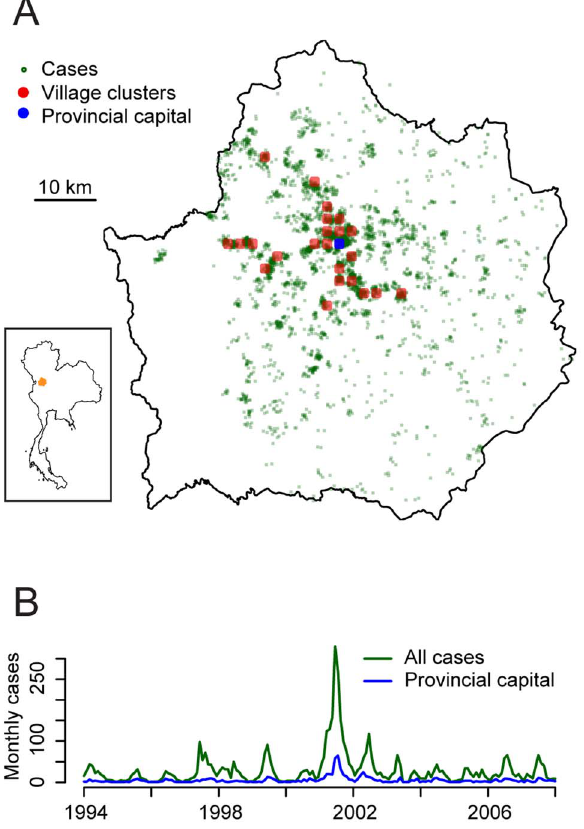
Figure 1. Spatial and temporal distribution of cases that presented at KPPH (1994–2008). (A) Map of case locations. The red circles mark the village clusters with at least 40 cases. (B) Total number of cases per month.